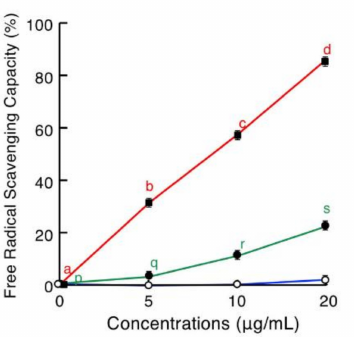
Figure 7. Antioxidative activities of brevinin-2SSb (red line), ranatuerin-2SSa (green line), and granuliberin-SSa (blue line). Serially diluted brevinin-2SSb, ranatuerin-2SSa, or granuliberin-SSa incubated with ABTS + in a U-bottom 96-well microplate at room temperature for 10 min. After incubation, A 734 values were measured, and the inhibition percentage of ABTS was calculated. Points and vertical bars represent means and SEM, respectively ( n = 4). Values with the same letters are not significantly di ff erent ( p ≥ 0.05). ABTS, 2,2 (cid:48) -azinobis-(3-ethylbenzothiazoline-6-sulfonate).